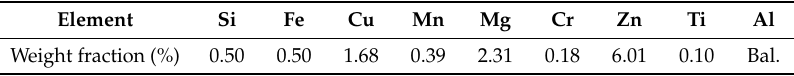
Table 1. Chemical composition (wt %) of extruded